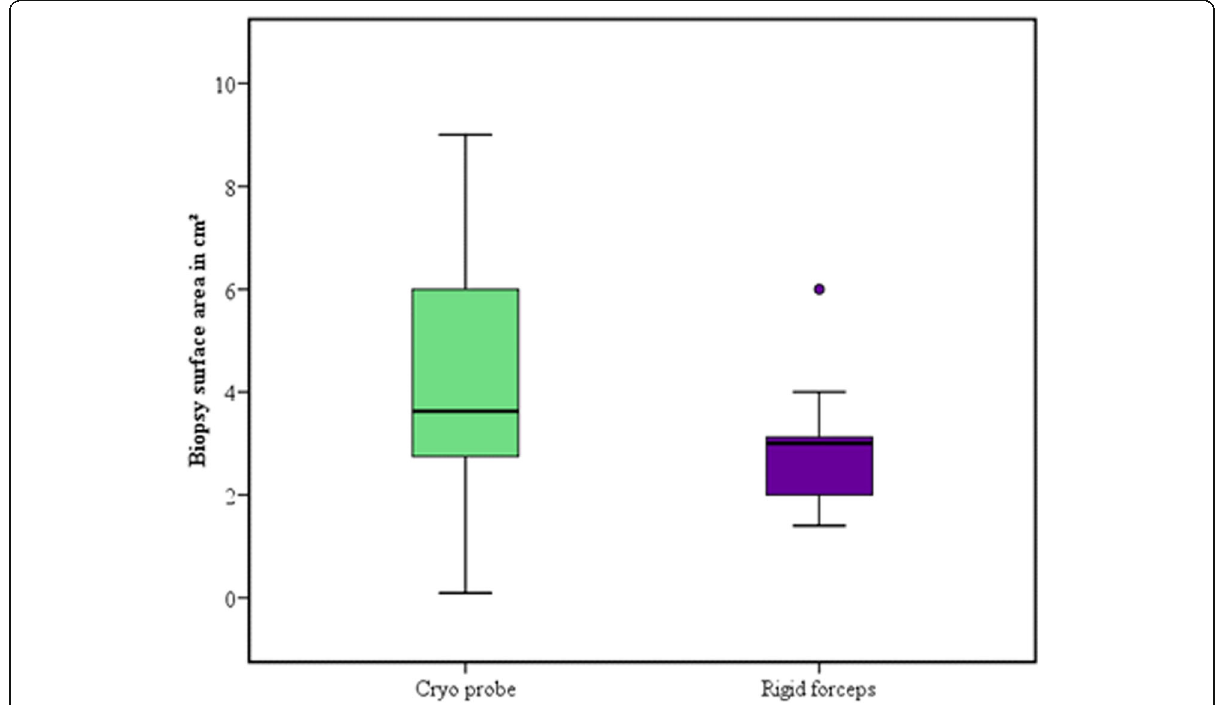
Fig. 3 Comparison between cryoprobe and rigid forceps according to biopsy surface area ( n =